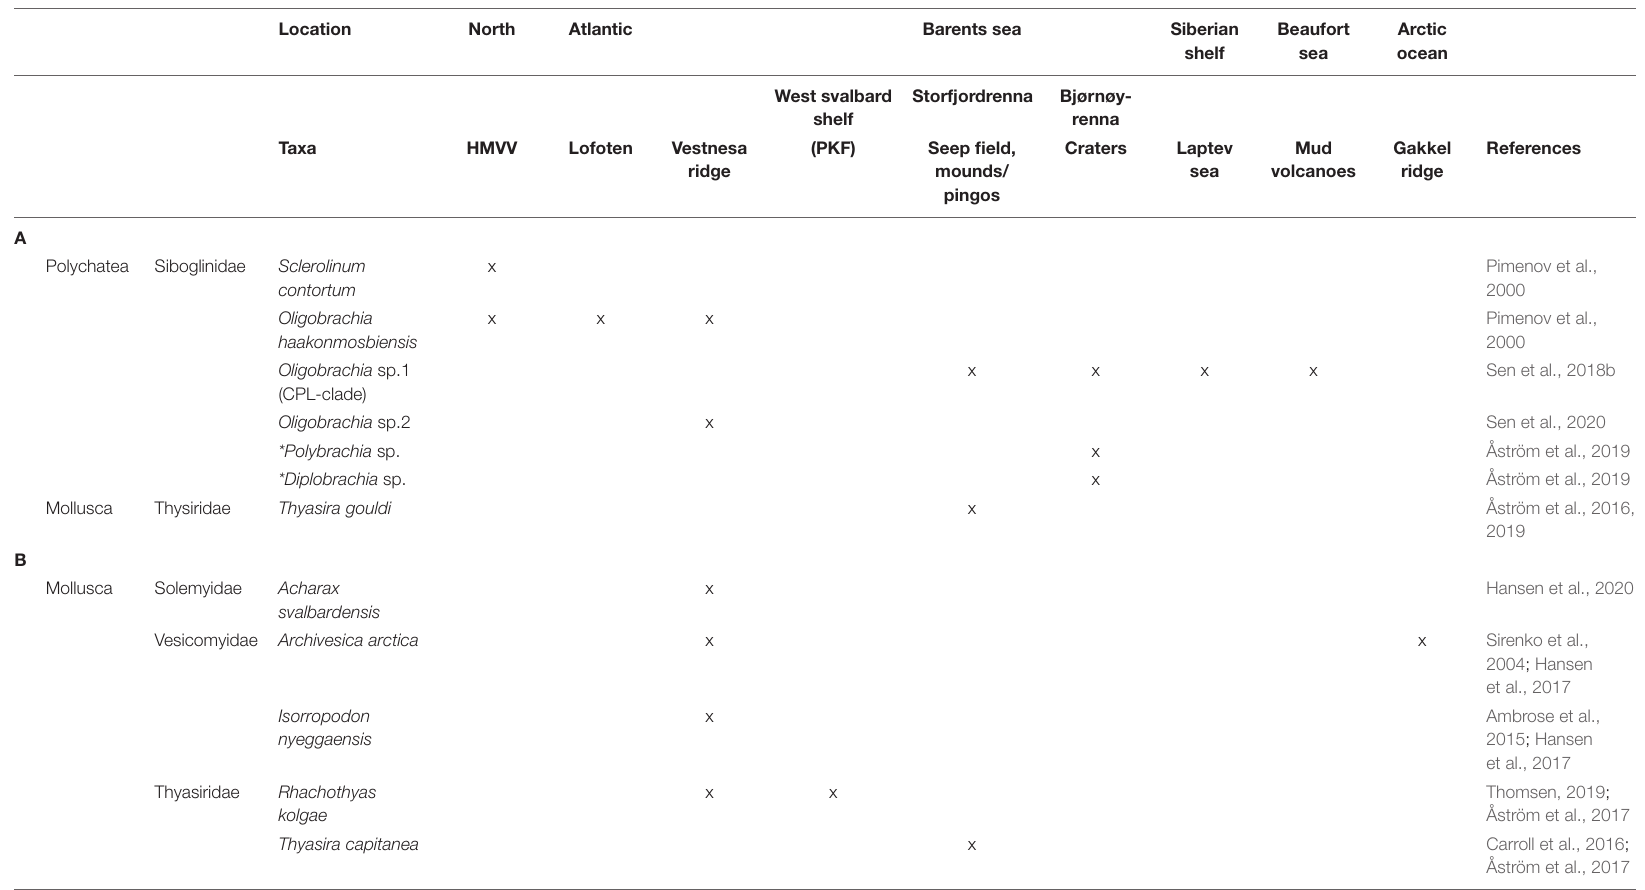
TABLE 1 | (A) Modern symbiotrophic taxa identified at Arctic cold seeps; locations where taxa are present are marked as “x.” (B) Recent fossil (records younger than ∼ 20,000 years B.P.) of chemosymbiotic taxa identified from Arctic cold seep